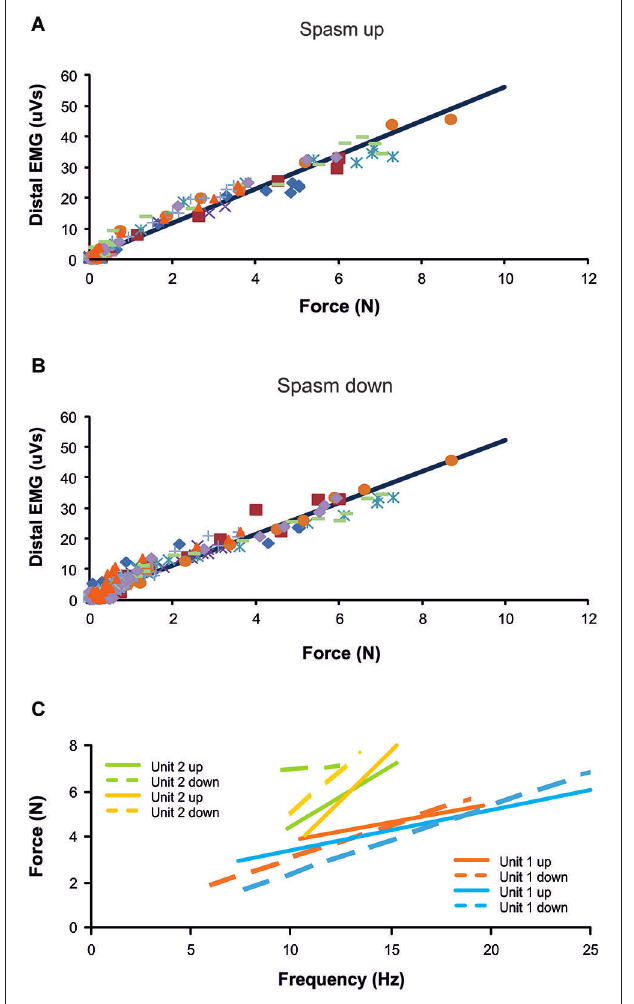
FIGURE 2 | Distal EMG-force relationship during the force rise (A; R 2 = 0.97) and fall (B; R 2 = 0.95) of 10 spasms (different symbols) recorded from one subject. (C) Frequency-force relationship for 2 units, each followed during the force increase and decrease of two different spasms ( n = 4 spasms total). Data are from the same subject as in (A) and (B) .